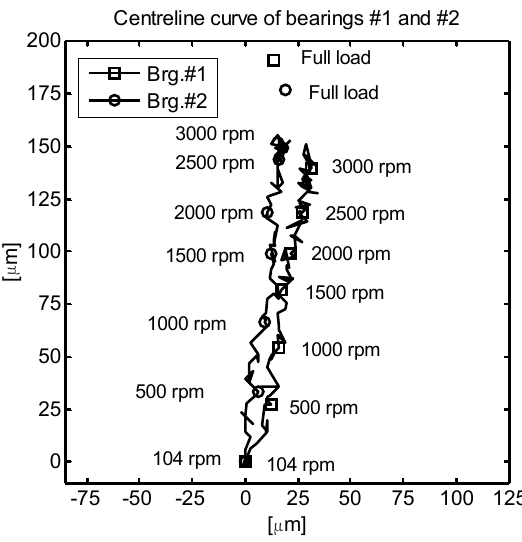
Fig. 11. Experimental centreline curves of the journal within bearings #1 and #2.